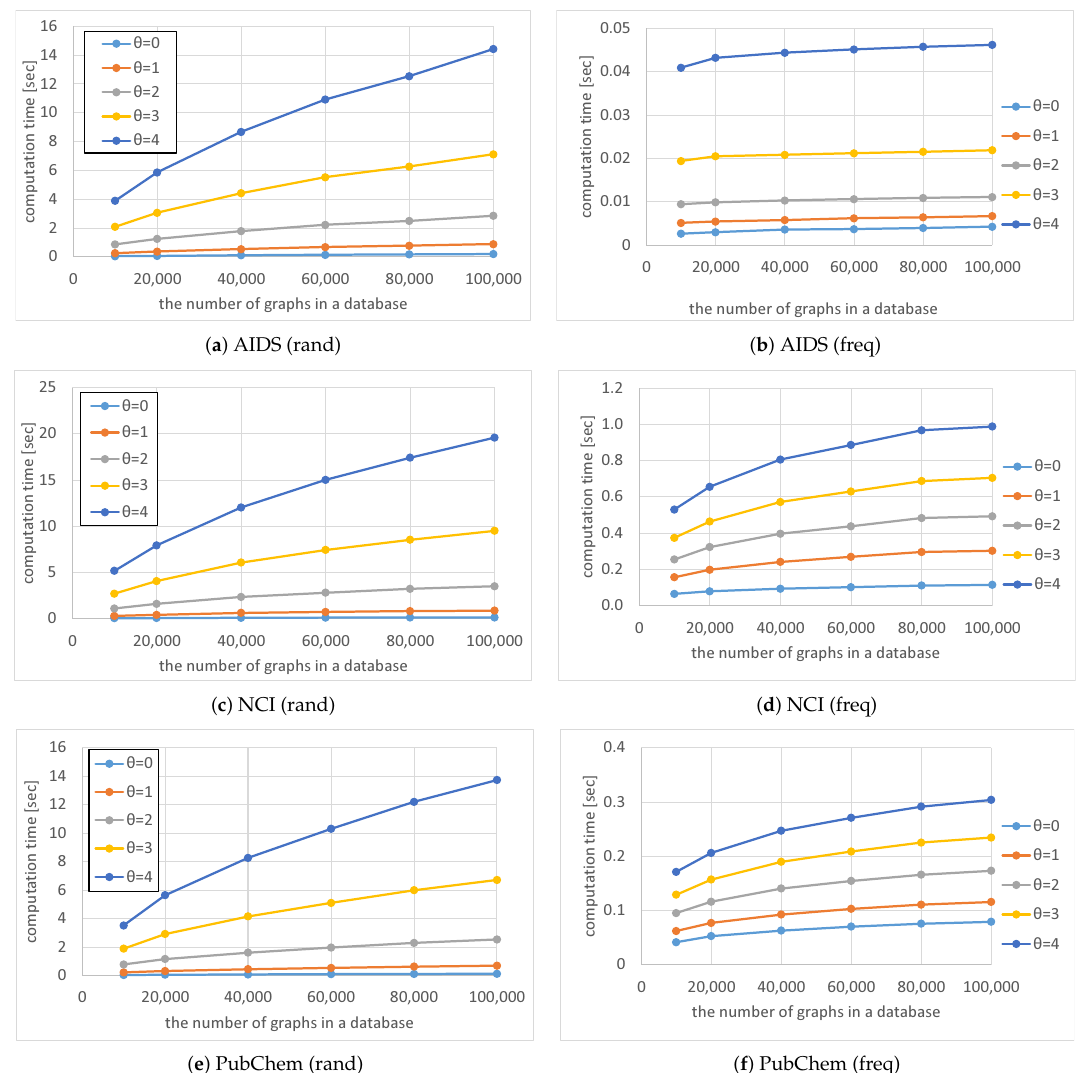
Figure 7. Average computation times t for various numbers of graphs | G | in a database and various thresholds θ